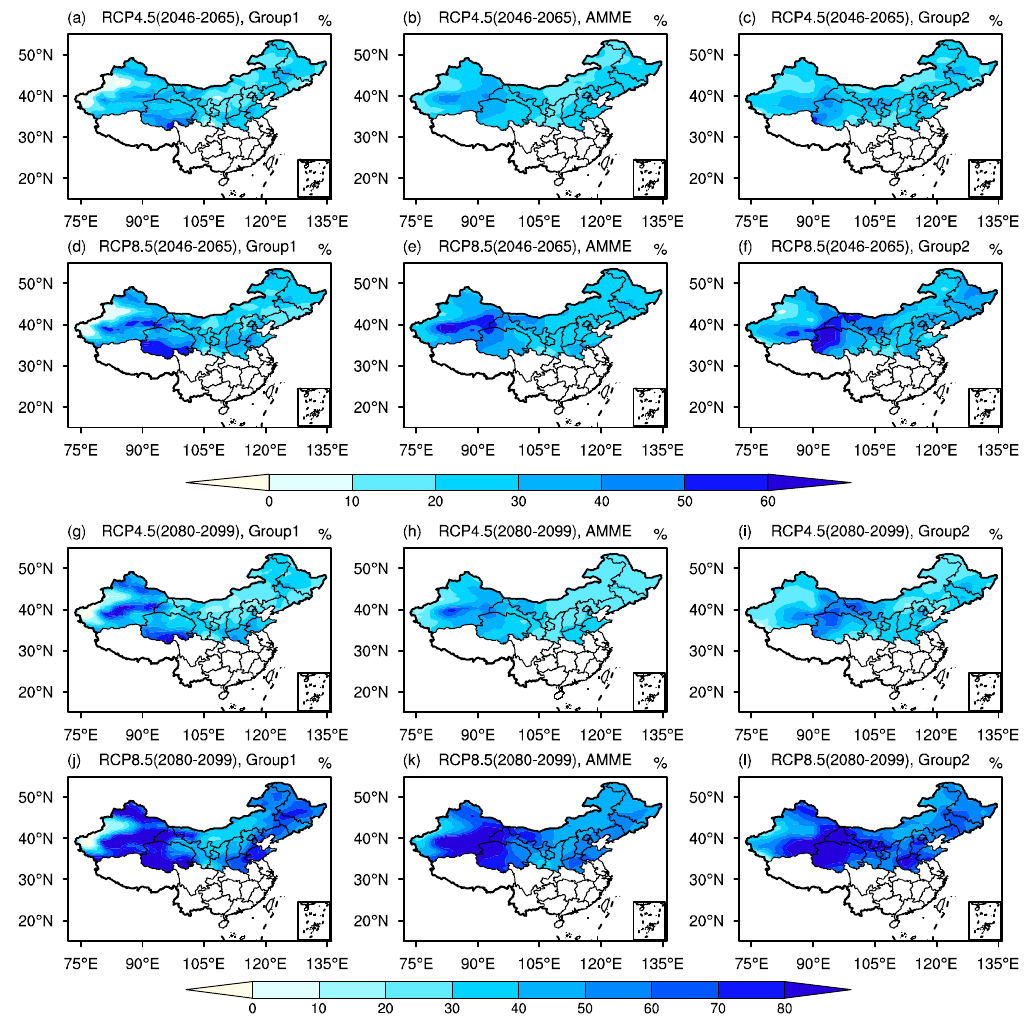
Figure 9. Projection change (%) of R95P from Group 1 (left column), AMME (middle column), and Group 2 (right column) under RCP4.5 and RCP 8.5 during the middle of the century (2046–2065) ( a – f ) and the end of the 21st century (2080–2099) ( g – l ).